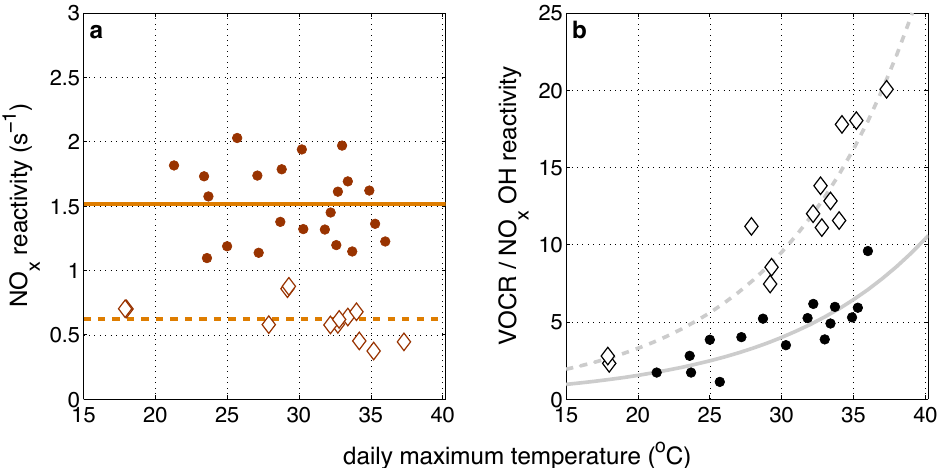
Fig. 4. (a) Daily average (10:00–14:00LT) NO x R (s − 1 ) versus the daily maximum temperature ( ◦ C) separated by weekdays (closed circles) and weekends (open diamonds). Weekdays are Tuesdays–Fridays. Weekends are Saturdays, Sundays, and Memorial Day (31 May 2010). Mondays and Saturdays are considered transition days, as they are influenced by carryover from the previous day. We omit Mondays for this weekend average value of 0.6s − 1 . (b) Total VOCR per unit NO x R for weekdays (closed circles) and weekends (open diamond) versus the